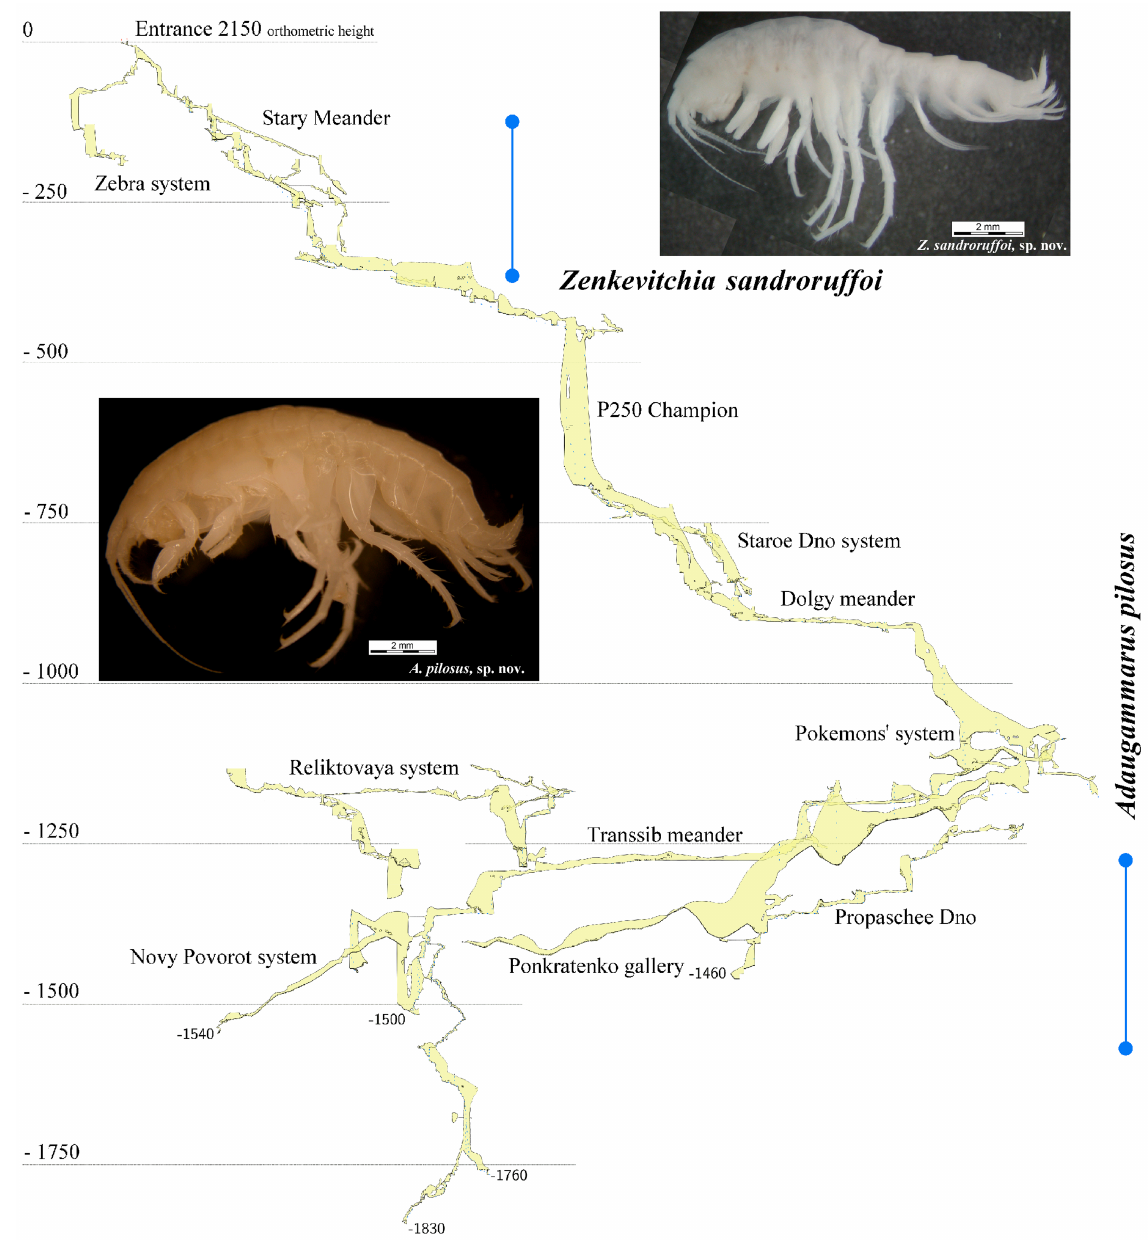
Fig. 2. Vertical distribution of amphipod species in the Sarma Cave. Map adapted from Sidorov et al . (2014), compiled by V.V.